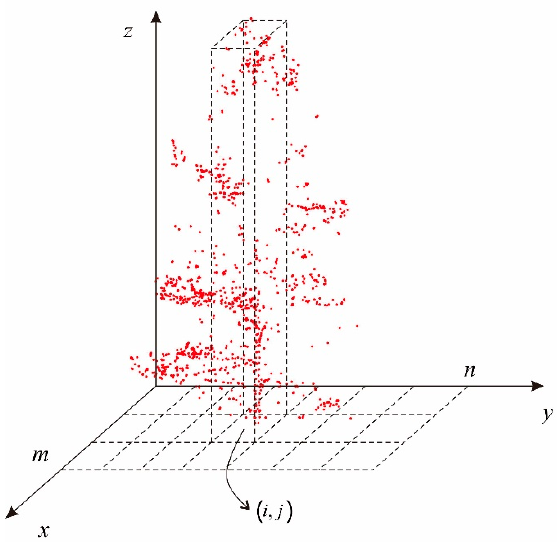
Figure 8. The sketch map of the barycenter calculation.